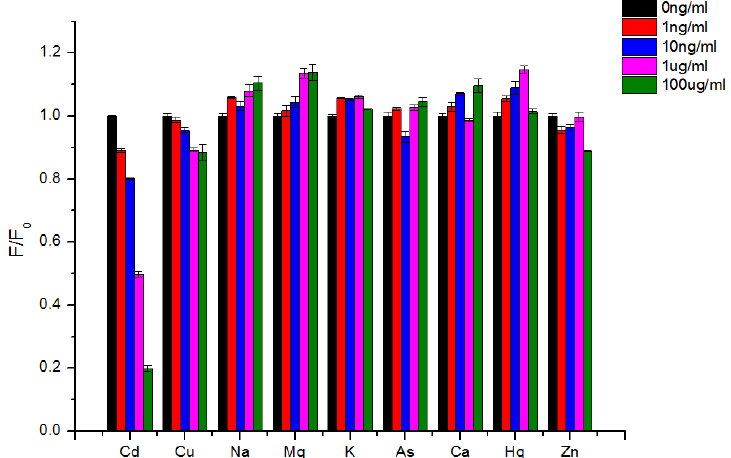
Figure 3. Changes in the relative fluorescence intensity ( F / F 0 ) with various metal ions.